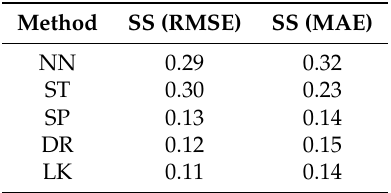
Table 4. RMSE- and MAE-based skill scores relative to the persistence for all nowcasting method used. Both RMSE and MAE are calculated within the domain DS of existence of each